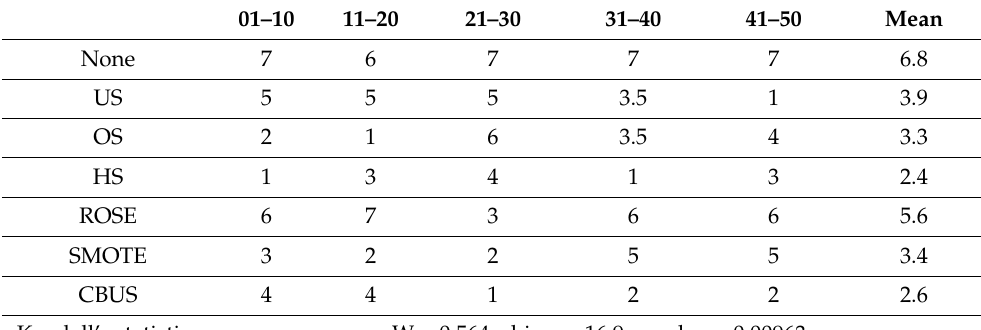
Table 20. Ranks of DBT for SVM classifier for varying levels of